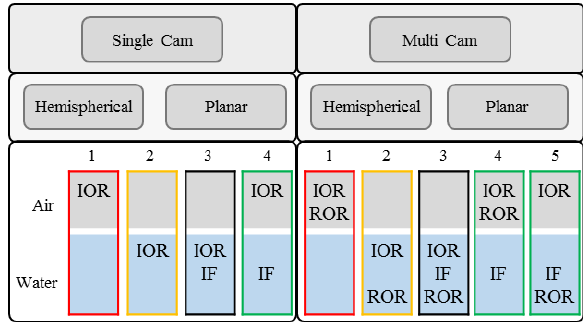
Figure 1. System components, calibration approaches for photogrammetric underwater systems. Left side illustrates options of configuration for single camera usage; right side illustrates options for multi-camera systems. Red frames indicate unreasonable strategies, yellow frames indicate standard strategies using standard software, black frame strategies are not part of this work but theoretically possible, green frames indicate explicit modelling of refractive effects using a known